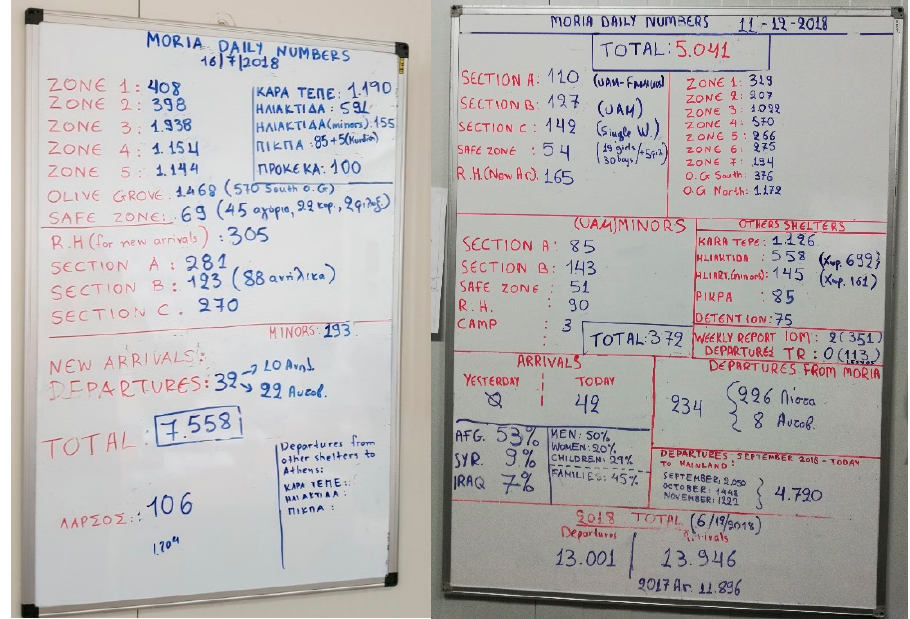
Figure 4. Dashboard at the Moria camp noting daily hosting (16 July ( left ) and 11 December ( right ) of 2018).